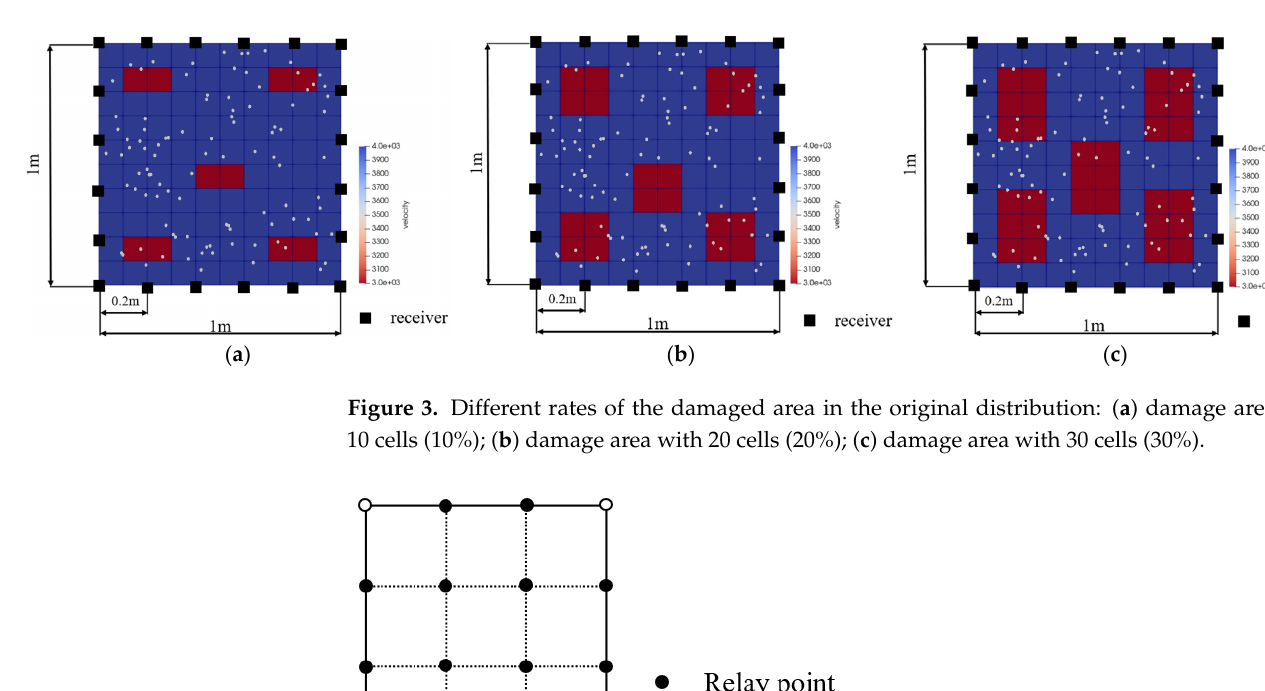
Figure 4. The setting of the relay points for each cell.